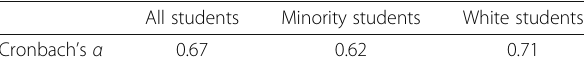
Table 7 Reliability statistics for “ Why did you choose your major?